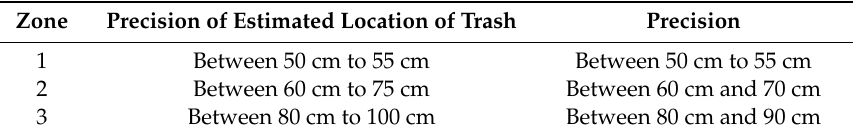
Table 2. Localization precision of the Smart Cane navigation system.